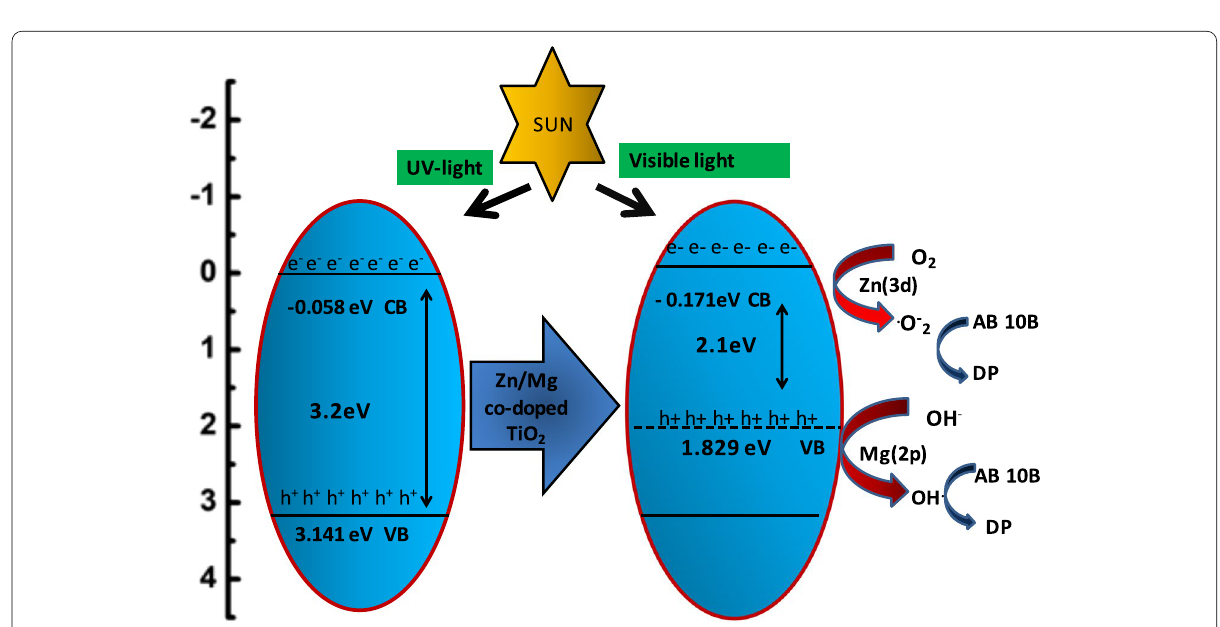
Fig. 18 Plausible mechanism for degradation of AB 10B using Zn/Mg co-doped TiO